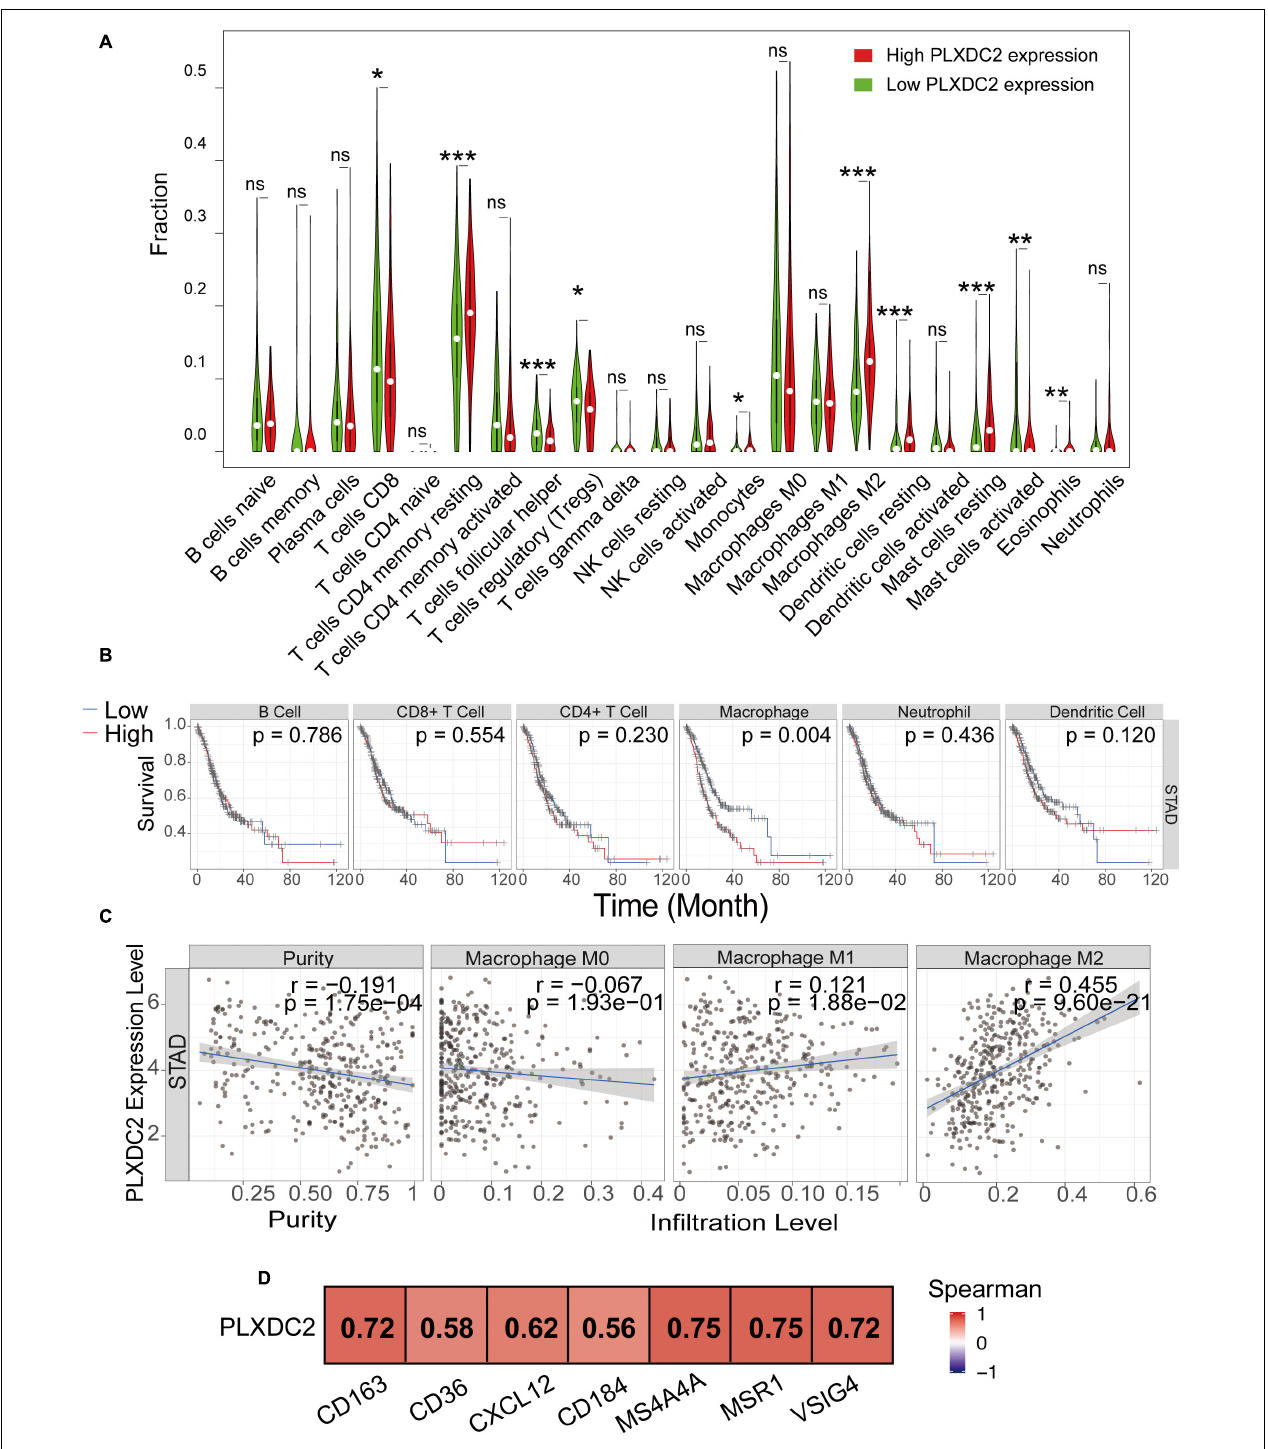
FIGURE 5 | The correlation of PLXDC2 correlation with M2 macrophages and gene markers. (A) The ratio differentiation of 22 kinds of immune cells between TCGA STAD tumor samples with high or low PLXDC2 expression relative to the median PLXDC2 expression level; the Wilcoxon rank sum test was used as the significance test. “ns” represents p > 0.05, * represents 0.05 > p > 0.01, ** represents 0.01 > p > 0.001, and *** represents p < 0.001. (B) Kaplan–Meier plots according to the proportions of 6 general types of immune cells (macrophages p = 0.004 by the log-rank test). (C) Scatter plot showing the correlation of M0, M1, and M2 macrophages proportions with PLXDC2 expression ( p < 0.05) generated by TIMER 2. The blue line in each plot was a fitted linear model that indicates the proportion of immune cells and the expression of PLXDC2; the Pearson coefficient was used for the correlation test. (D) The relationship between PLXDC2 and the immune markers of M2 macrophages. A redder color suggests a better correlation according to the Spearman test generated by TIMER 2.